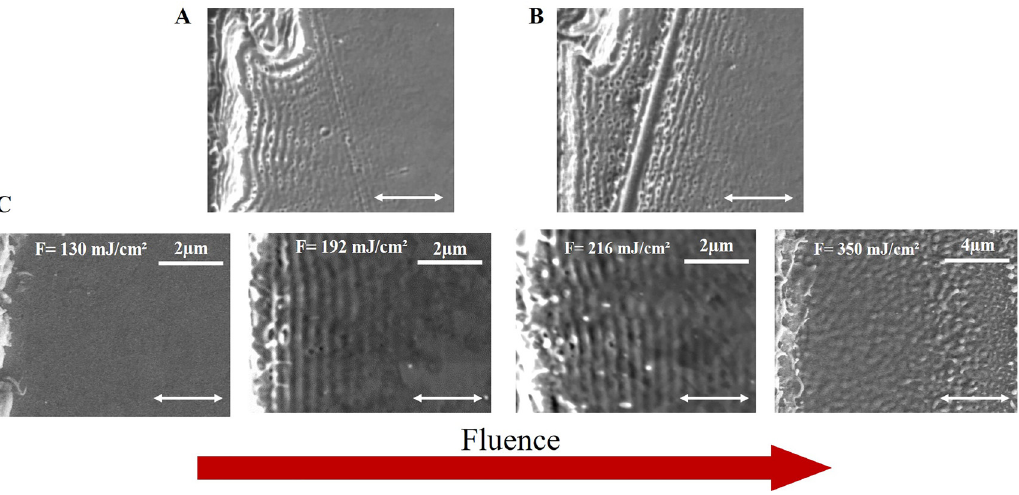
Figure 2: SEM images of LIPSS with a step edge located at the very left side of each image. (A)SEMpictureofLIPSSattheroughstepedgeirradiatedwithafluenceof F =(214 ± 22)mJ/cm 2 .(B)SEMpictureofLIPSSatthestepedgewith an additional scratch irradiated with a fl uence of F = (223 ± 23) mJ/cm 2 . (C) SEM pictures of LIPSS at the step edge with increasing incident fl uence. The white horizontal double-arrows show the direction of the laser